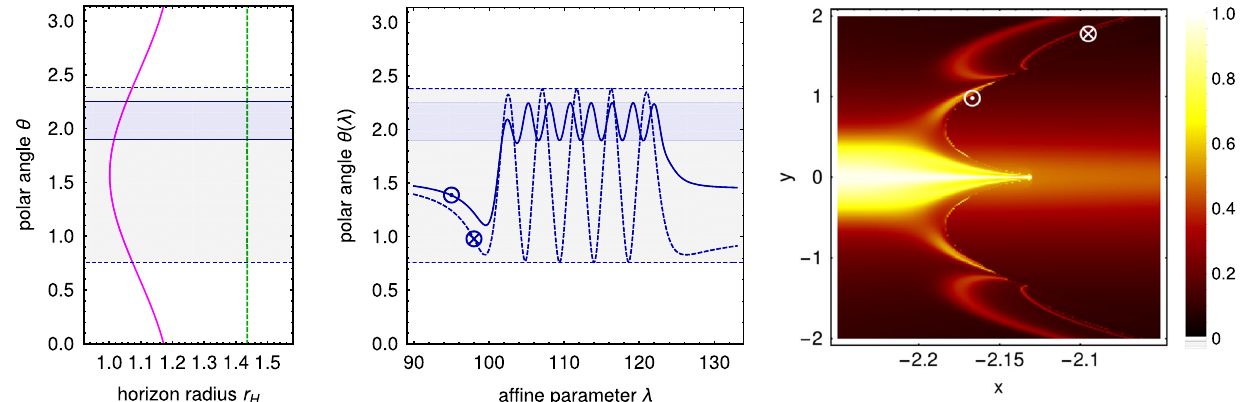
Fig. 1 Left-hand panel: parametric curves of the spherical Kerr hori- zon (dashed green) and the non-spherical horizon of the local, regular black-hole( M exp with (cid:11) NP = 0 . 2556 m ≈ (cid:11) NP,crit ),bothatspinparame- ter a = 0 . 9 m .Middlepanel:Differentexplicittrajectories(asafunction of affine parameter λ ) initiated at image points on the shadow boundary (markedintheright-handpanel)probingsymmetric(dashed)andasym-